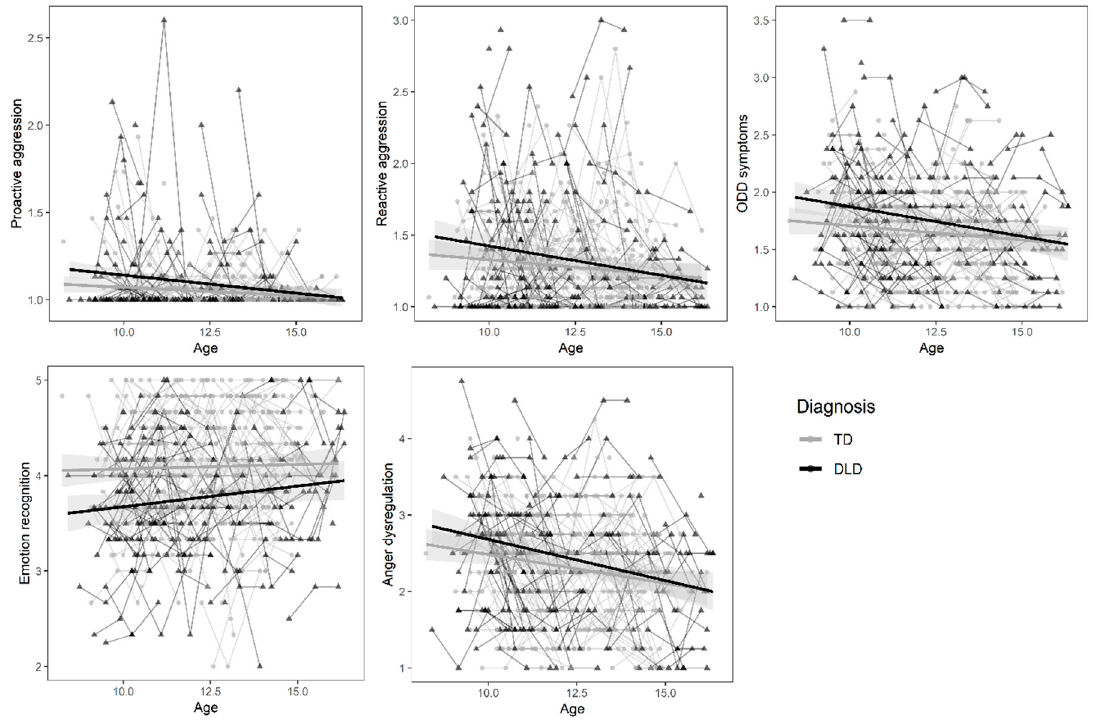
Figure 2. Representation of the raw data for proactive aggression, reactive aggression, Oppositional Deviant Disorder (ODD) symptoms, emotion recognition and anger dysregulation. The regression lines represent the mean level in children with Developmental Language Disorder (DLD) and typically developing children (TD) across time with 95% confidence interval.